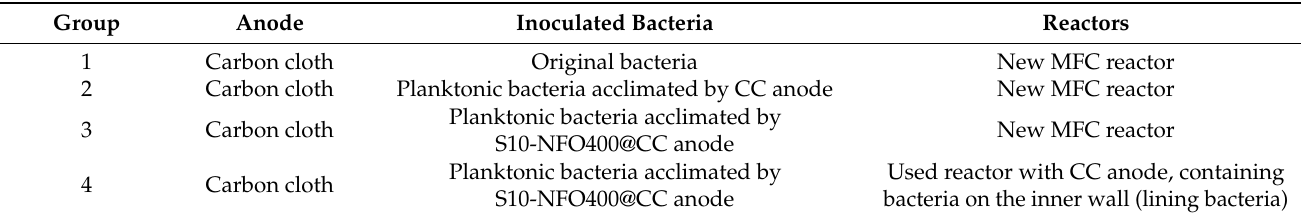
Table 1. The specific description of different